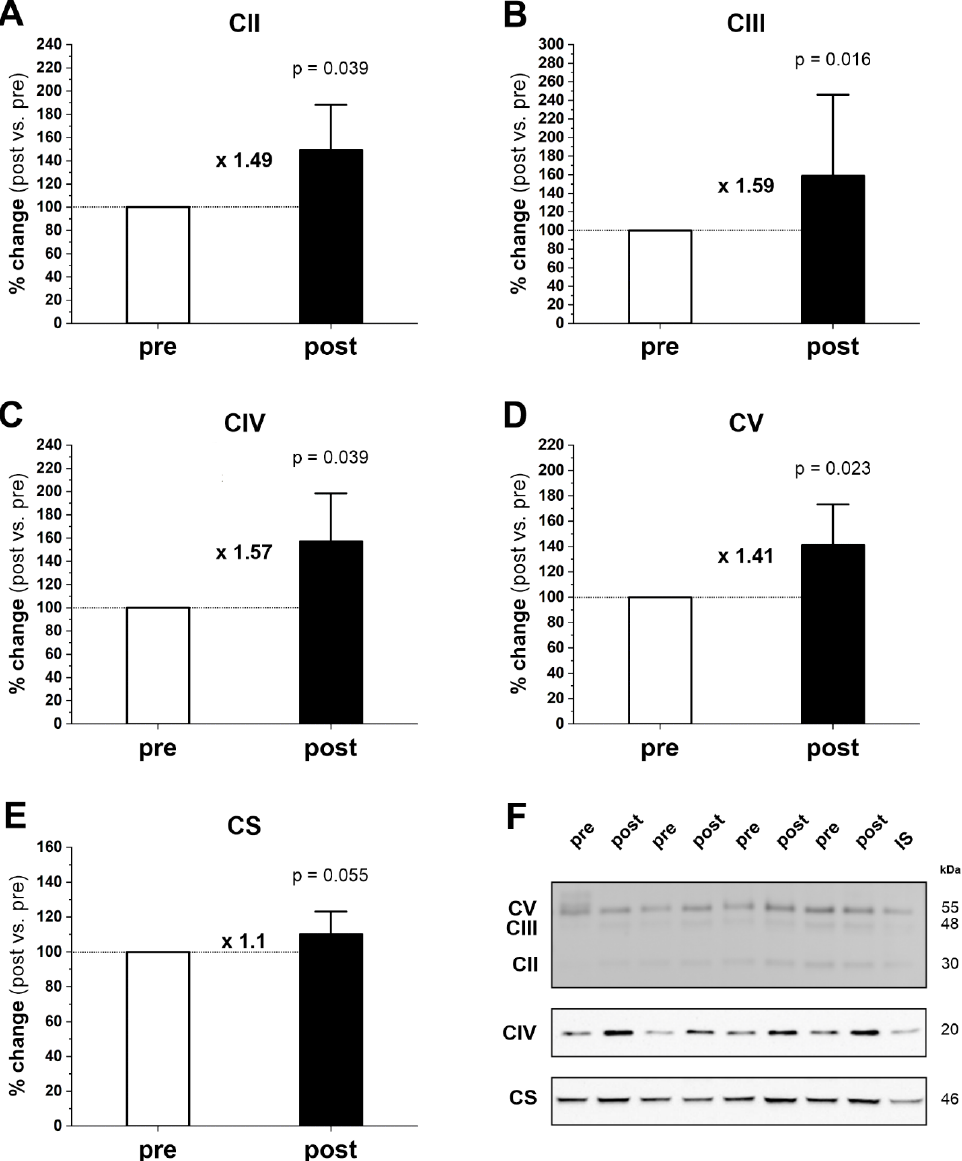
Figure 3. Effect of 20-week endurance training on the protein level of OXPHOS complexes, CII (subunit SDHB) ( A ), CIII (subunit UQCRC2) ( B ), CIV (subunit COXII) ( C ) and ATP synthase (CV, subunit ATP5A) ( D ), and CS ( E ) in human gastrocnemius muscle. Representative Western blots of four subjects are shown ( F ). The internal standard (IS) is a human vastus lateralis muscle sample. The results are expressed as percentage change after training (post) in relation to the status before training (pre), which is presented in the graph as 100%. Data are presented as the mean ± SD. The nonparametric Wilcoxon sign rank test with a two-sided p-value is shown. Post- vs.